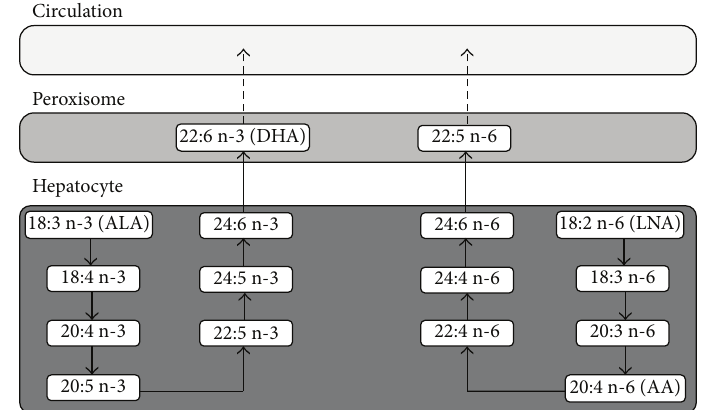
Figure 2: Synthesis of PUFAs in the liver. Precursors of n-3 and n-6 polyunsaturated fatty acid (PUFA) 𝛼 -linolenic (ALA; 18:3 n-3) and linoleic acid (LNA; 18:2 n-6) can be desaturated and elongated. This leads to the synthesis of long-chain PUFAs, including docosahexaenoic acid (DHA; 22:6 n-3), but also arachidonic acid (AA; 20:4 n-6) which are carried into the blood as free forms or lipoproteins. Both, n-3 and n-6 long-chain PUFAs, compete for their synthesis (for desaturation and elongation), meaning that PUFAs intake significantly impacts their cerebral incorporation